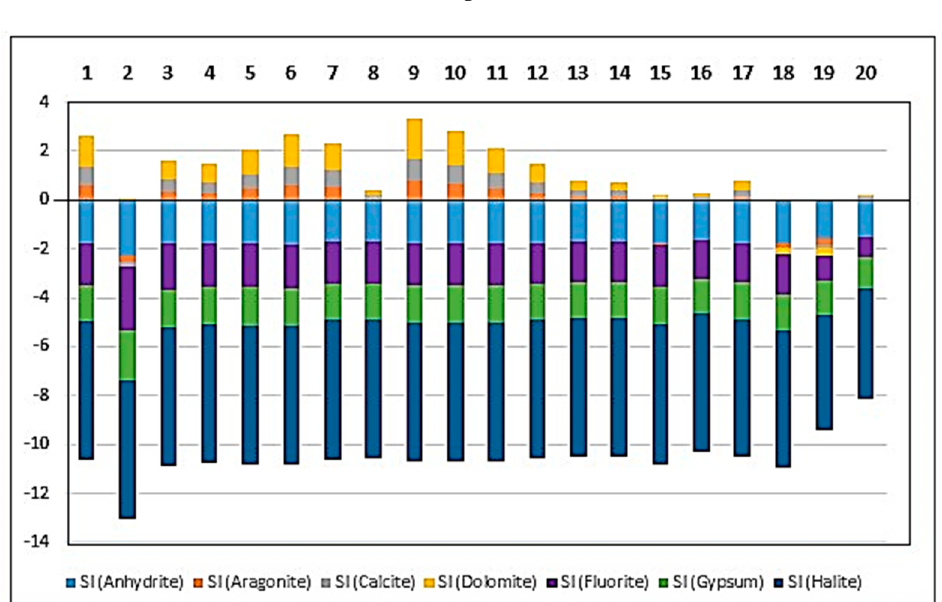
Figure 7. Saturation indices for water samples from Sochagota Lake. IAP: ion activity product; KT: equilibrium constant at a